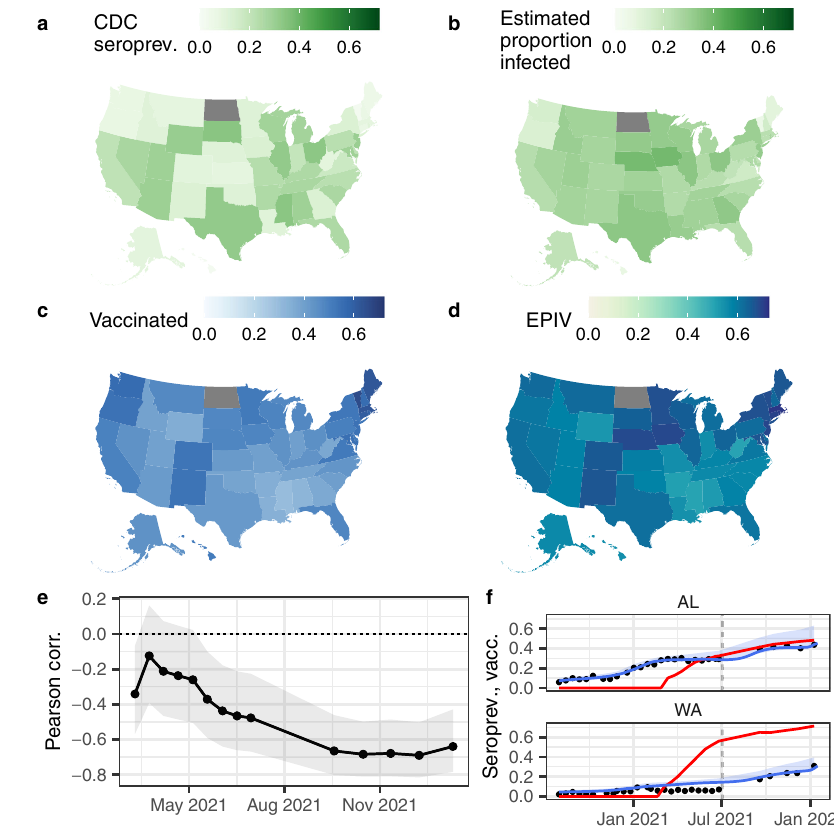
Fig.4|Spatialpatternsandcorrelations. SpatialvariationinJuly2021(round24) in ( a ) CDC nationwide serosurvey seroprevalence, ( b ) estimated proportion infected, ( c ) proportion of the population with a complete series of a vaccine, ( d ) estimated proportion infected and/or vaccinated (EPIV; assuming independent probabilities of having hada natural infection and being vaccinated),( e )round-by- round Pearson correlation between the proportion of the population vaccinated and the estimated proportion infected (shaded areas show the 95% uncertainty intervals for a two-sided test), and ( f ) example time series of seroprevalence